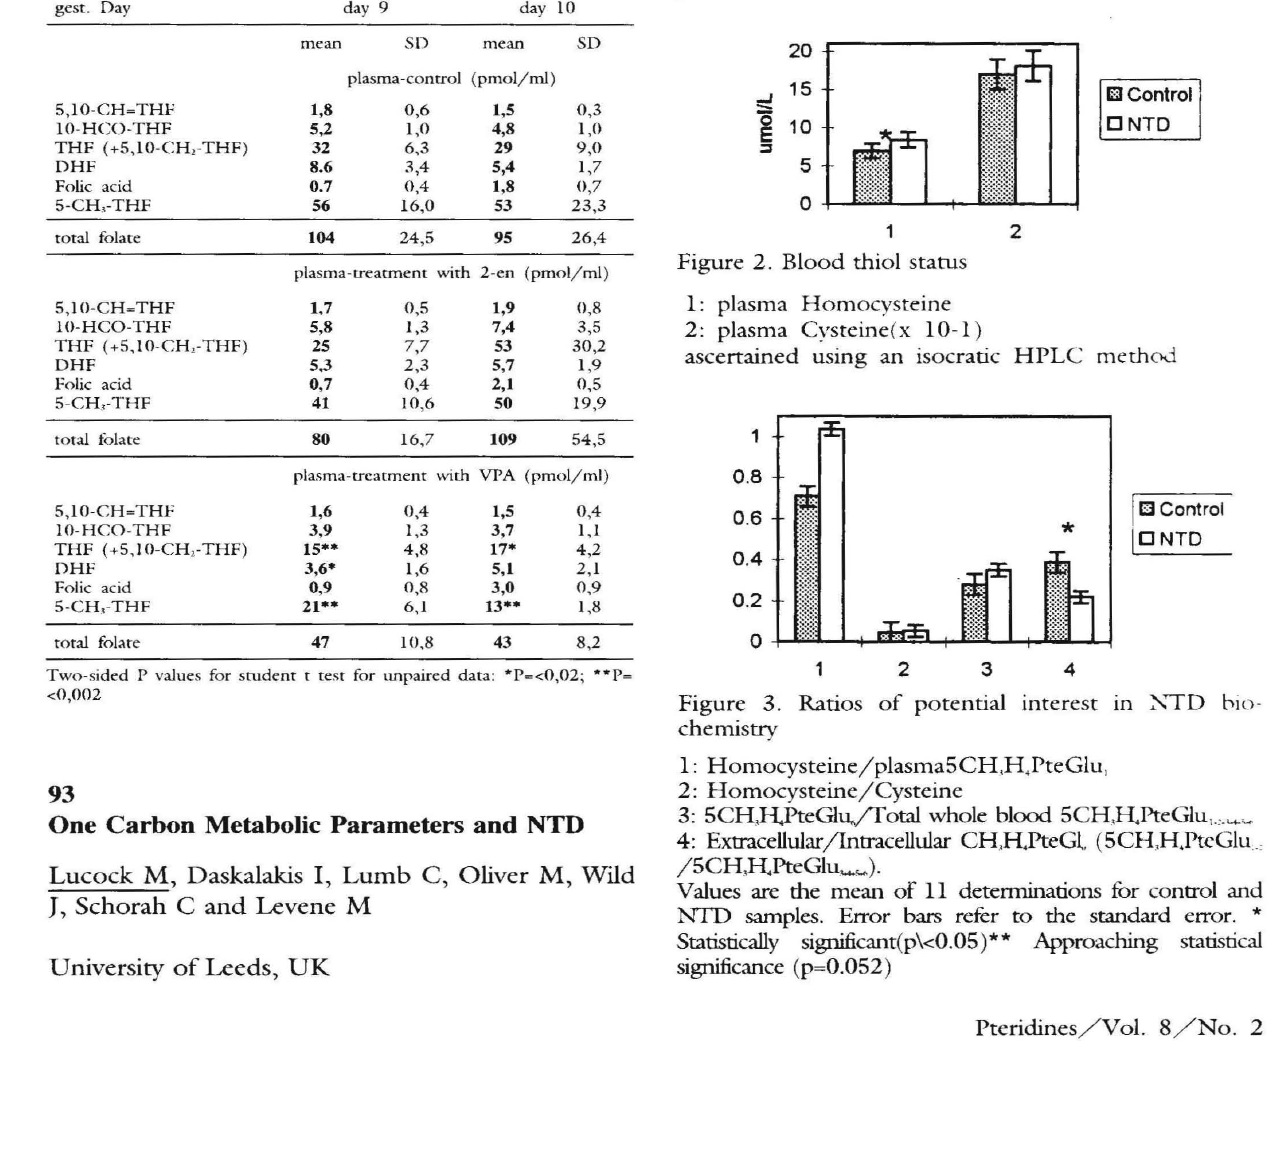
Figure 2. Blood thiol status 1: plasma Homocysteine 2: plasma Cysteine( x 10·1 ) ascertained using an isocratic HPLC method